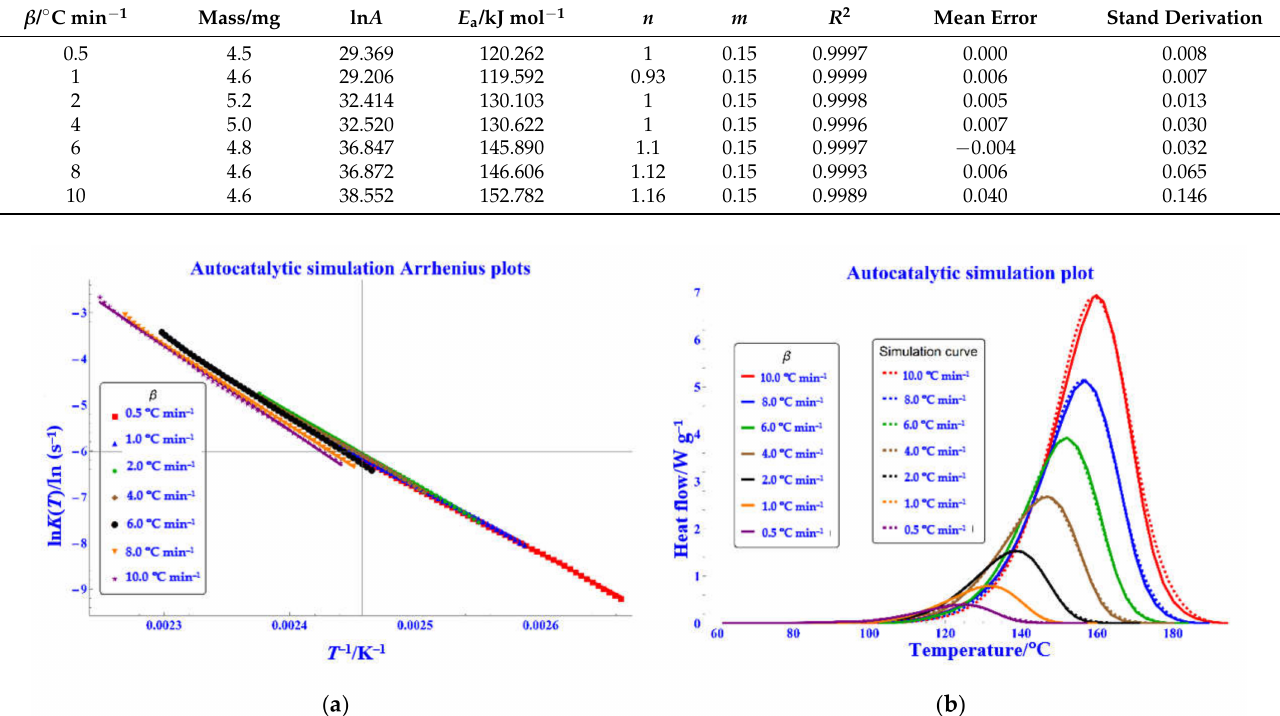
Figure 14. Autocatalytic model method ( a ) Arrhenius plots; ( b ) simulation curves by autocatalytic model kinetic